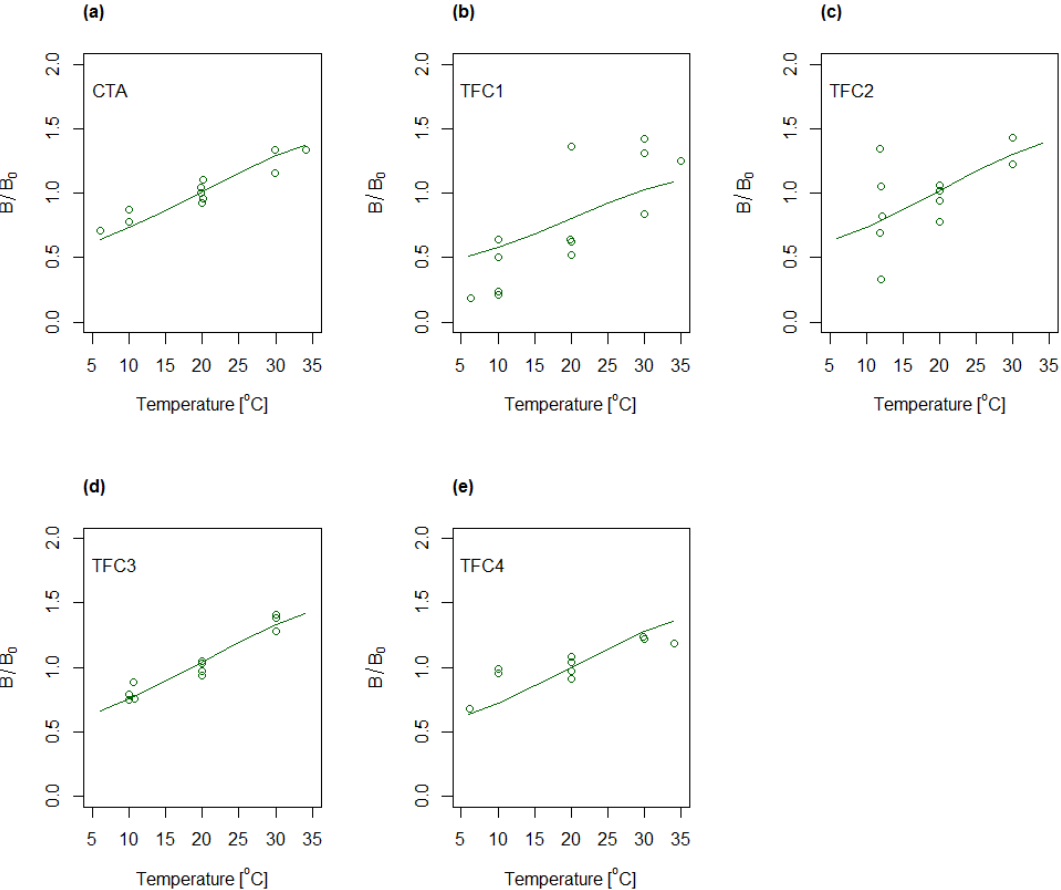
Figure 6. Relative changes in salt permeability as function of temperature for ( a ) CTA; ( b ) TFC1; ( c ) TFC2; ( d ) TFC3 and ( e ) TFC4. Concentration dependency is implicitly shown for each temperature by multiple data points representing different concentrations. Solid lines represent the regression models following Equation (7).